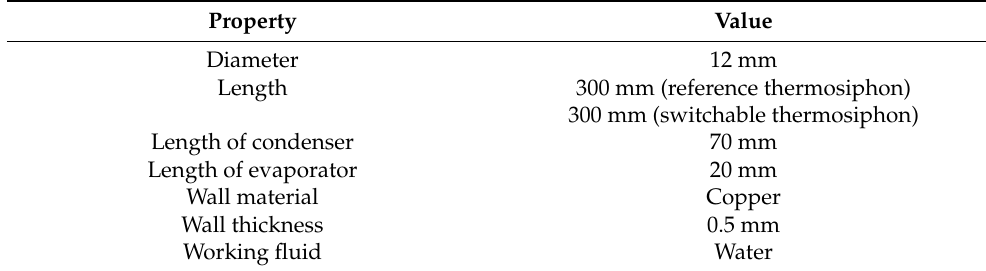
Table 1. Specifications of the fabricated